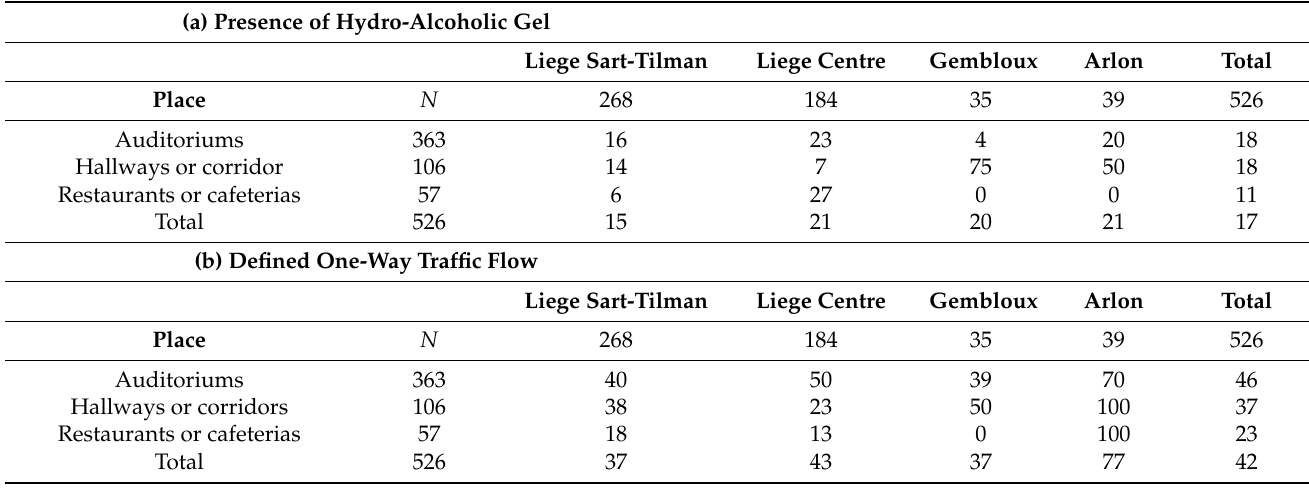
Table 2. Percentage of places without: (a) presence of hydro-alcoholic gel and (b) defined one-way traffic flow. (a) Presence of Hydro-Alcoholic